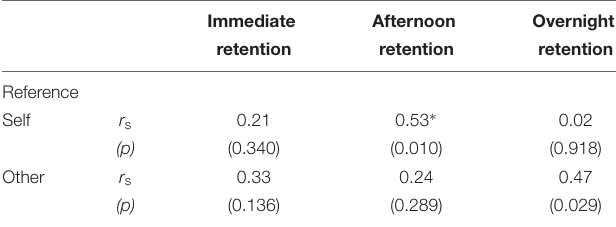
TABLE 1 | Relationship (Spearman’s r ) between mean dwell time (DT) during self- and other-reference trials and retention accuracy for corresponding